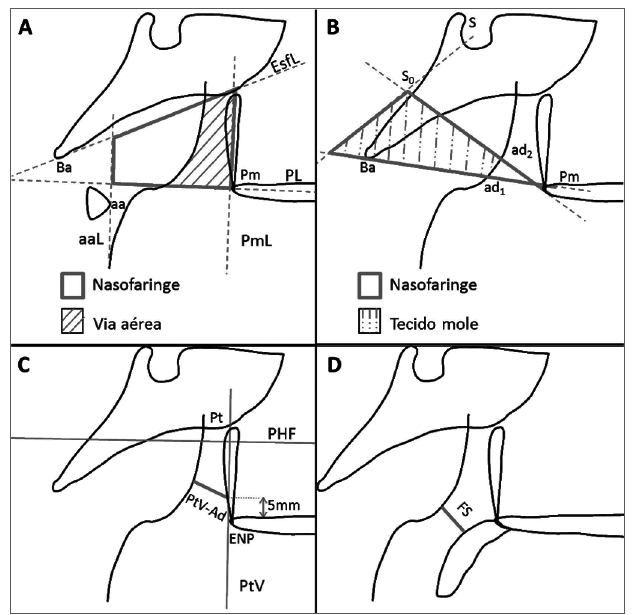
Figura 2. Ilustrações dos parâmetros de RC. (A): Ba: básio (ponto mais inferior sobre a margem anterior do forame magno); EsfL: Linha do esfenoide (tangente à borda inferior do osso esfenoide com registro em Ba); PL: Linha do palato (da espinha nasal anterior à posterior); Pm: pterigomaxilar (a intersecção do contorno do assoalho nasal com o contorno posterior da maxila); PmL: Linha pterigomaxilar (perpendi